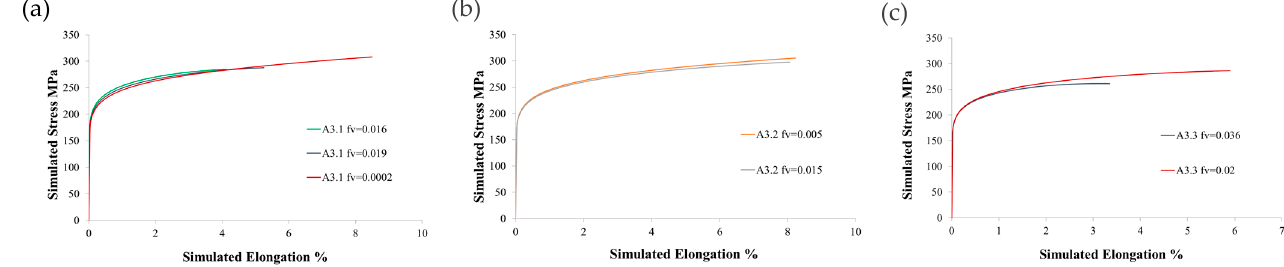
Figure 15. RVE Simulation Results After Elongation Correction According to Test Results of A3 set Specimens: ( a ) A3.1; ( b ) A3.2; ( c ) A3.3.